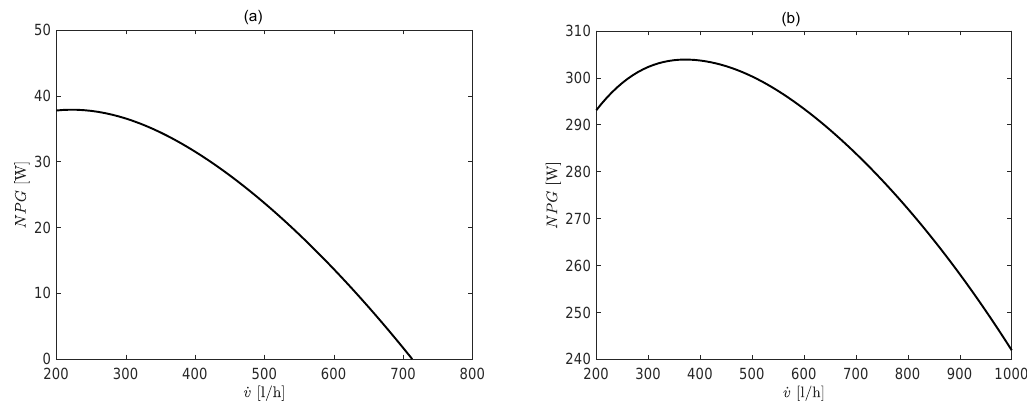
Figure 12. Net Power Gain vs. coolant flow rate in January ( a ) and July ( b ) for Catania